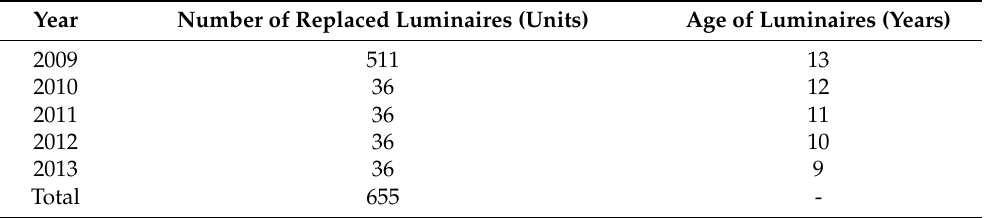
(Table 1). The remaining luminaires were successively replaced between 2010 and 2013 (an average of 64 luminaires per year). Table 1. Summary data on the age of luminaires. Year Number of Replaced Luminaires (Units) Age of Luminaires (Years)